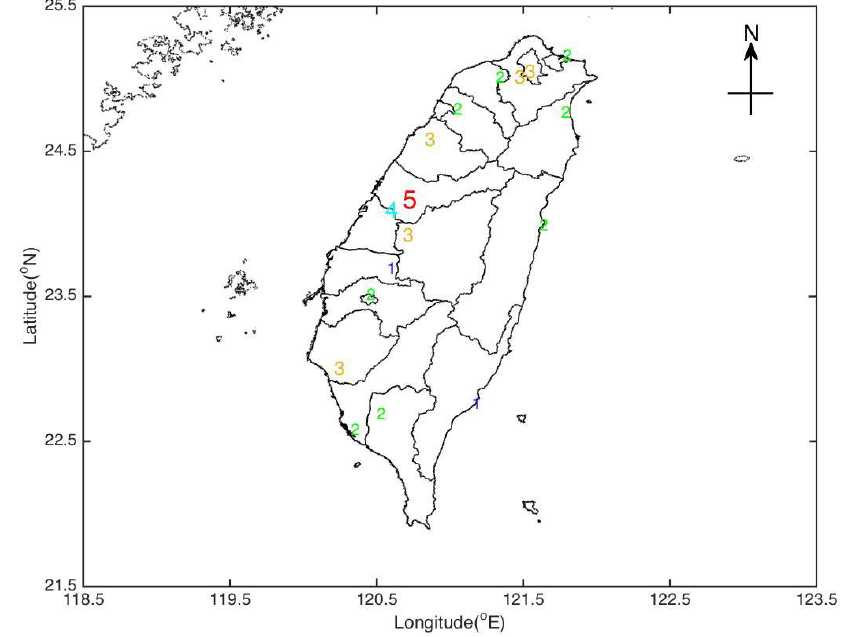
Figure 7. The intensity distribution analyzed by our approach for the earthquake occurring on 27 March 2013.